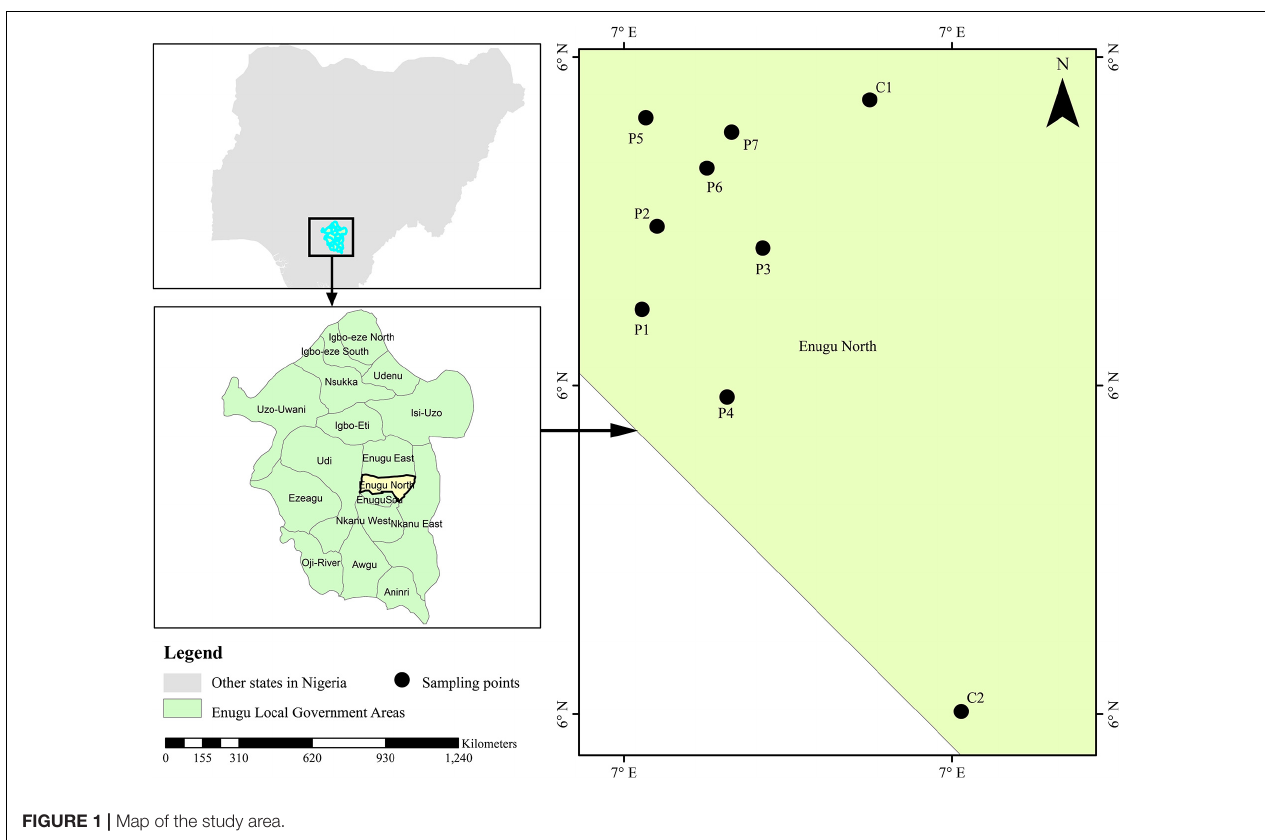
FIGURE 1 | Map of the study area.